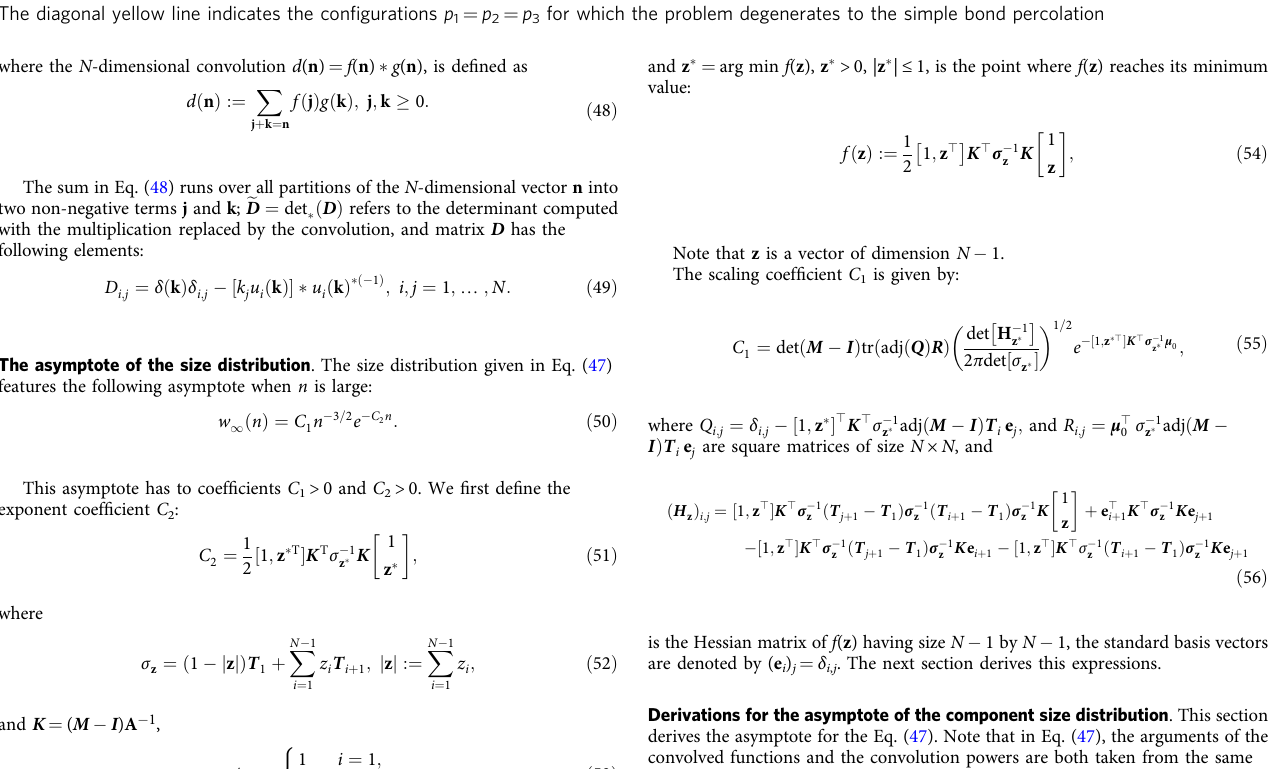
Fig. 6 Colour-dependent percolation in a network with three colours. a , b Surfaces containing critical con fi gurations of vector p (critical manifolds) in the network model with: a α = 0 and b α = 0.1. c , d Manifolds containing p -con fi gurations for which C 2 is small (isosurface C 2 = 0.02) are computed for: c α = 0 and d . α = 0.1. The red-blue colouring is used for better visual distinction between the surface ’ s sides in a , b and manifold ’ s interior/exterior in c , d . The diagonal yellow line indicates the con fi gurations p 1 = p 2 = p 3 for which the problem degenerates to the simple bond